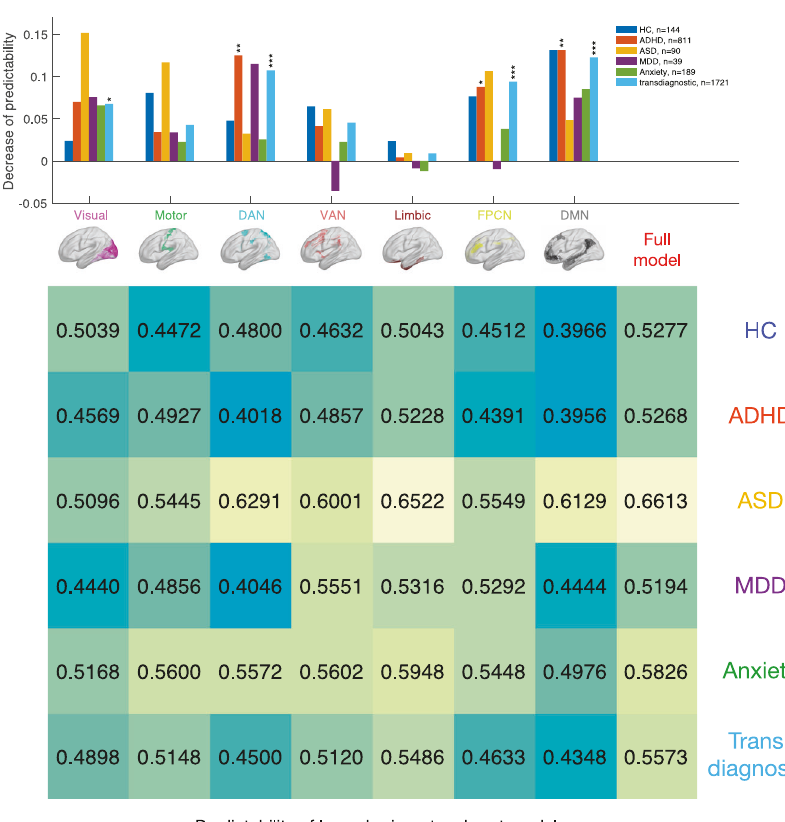
Fig. 3 Transdiagnostic and diagnosis-speci fi c connectome patterns in intellectual capacity prediction. The top bar plot displays the decrease of predictability for each diagnosis and brain network. The decrease of predictability is de fi ned as the difference in prediction performance between the “ standard model ” and leave-brain-network-out model, where the feature weights involving the brain network of interest are set to zero. Here, rain networks include visual network, somatomotor network (Motor), dorsal-attention network (DAN), ventral- attention network (VAN), limbic network, frontoparietal control network (FPCN) and default-mode network (DMN). The diagnosis groups include healthy control (HC), attention-de fi cit hyperactivity disorder (ADHD), autism spectrum disorder (ASD), major depressive disorder (MDD), anxiety disorders and the whole transdiagnostic population. *** P FDR < 0.001, ** P FDR < 0.01, * P FDR < 0.05. The brain maps indicate the corresponding brain region of each neural network. The bottom plot shows the predictability of leave-brain-network-out models and the “ standard model ” for each diagnosis group. Each of the brain networks is iteratively excluded from the prediction model by setting all feature weights involving the brain network of interest to zero. Boxed values indicate signi fi cant decrease after the removal of the corresponding brain network. For predictability, P FDR < 0.001 for all diagnosis